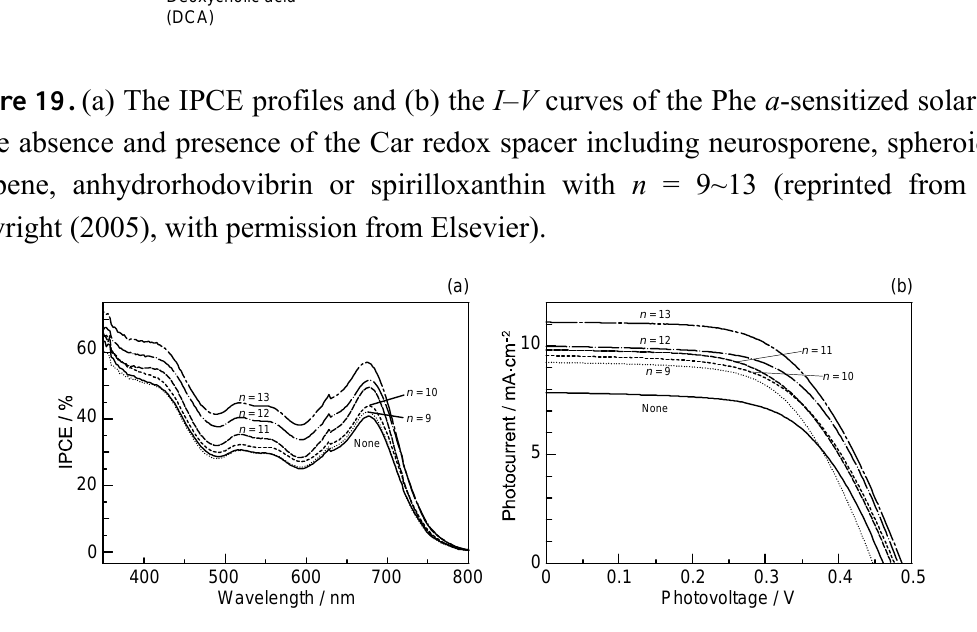
Table 2 in Supporting Information of Ref. [16] lists the relevant parameters; the values of IPCE 670 and η increase with n . Accordingly, the (the height at 670 nm), the integrated IPCE ( d IPCE ν ∫ ), J sc one-electron oxidation potential ( E ) of Car shifts to the negative side with n (Table 1 of Ref. [16]). ox and η vs . E . The correlations support our Figure 20 depicts the correlations, d IPCE ν ∫ , J sc ox original idea of the neutralization of Phe a • + with Car; spirilloxanthin ( n = 13) with the lowest E ox exhibits the highest potential of electron